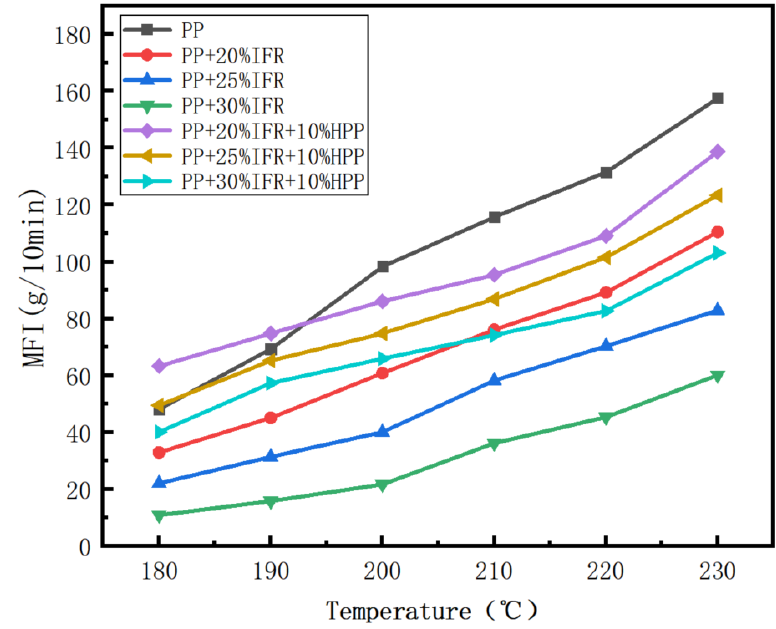
Figure 1. MFI of each group of flame-retardant-modified PP varies with temperature.